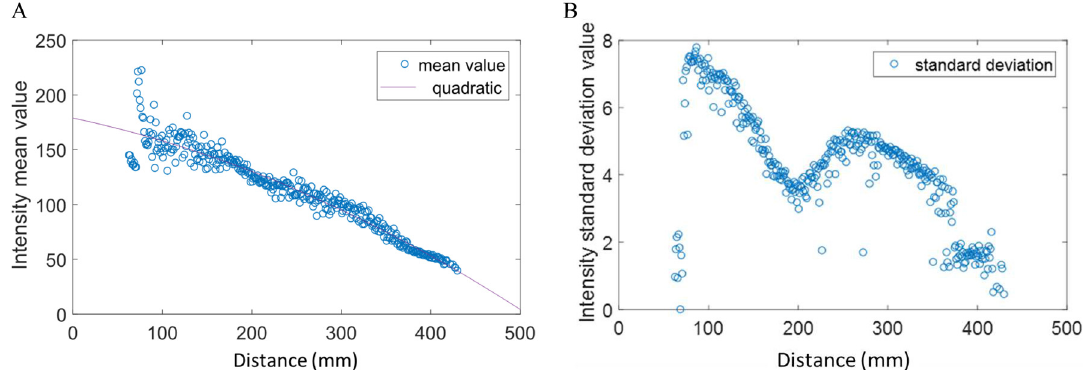
Fig 2. Mean and standard deviation intensity value of the hand regions with respect to the distance to the device. (A) Mean value, (B) standard deviation value.